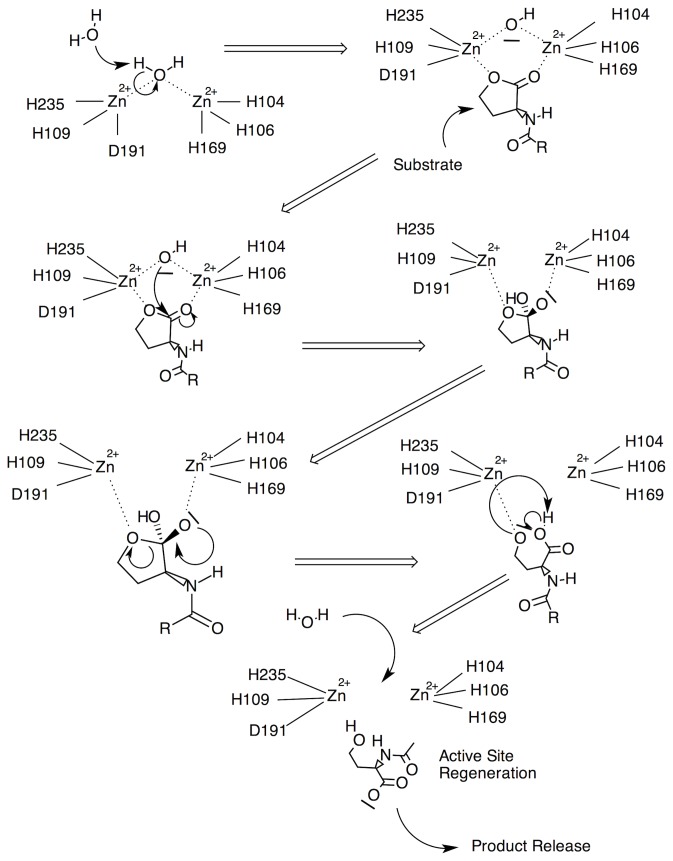
Proposed mechanism.